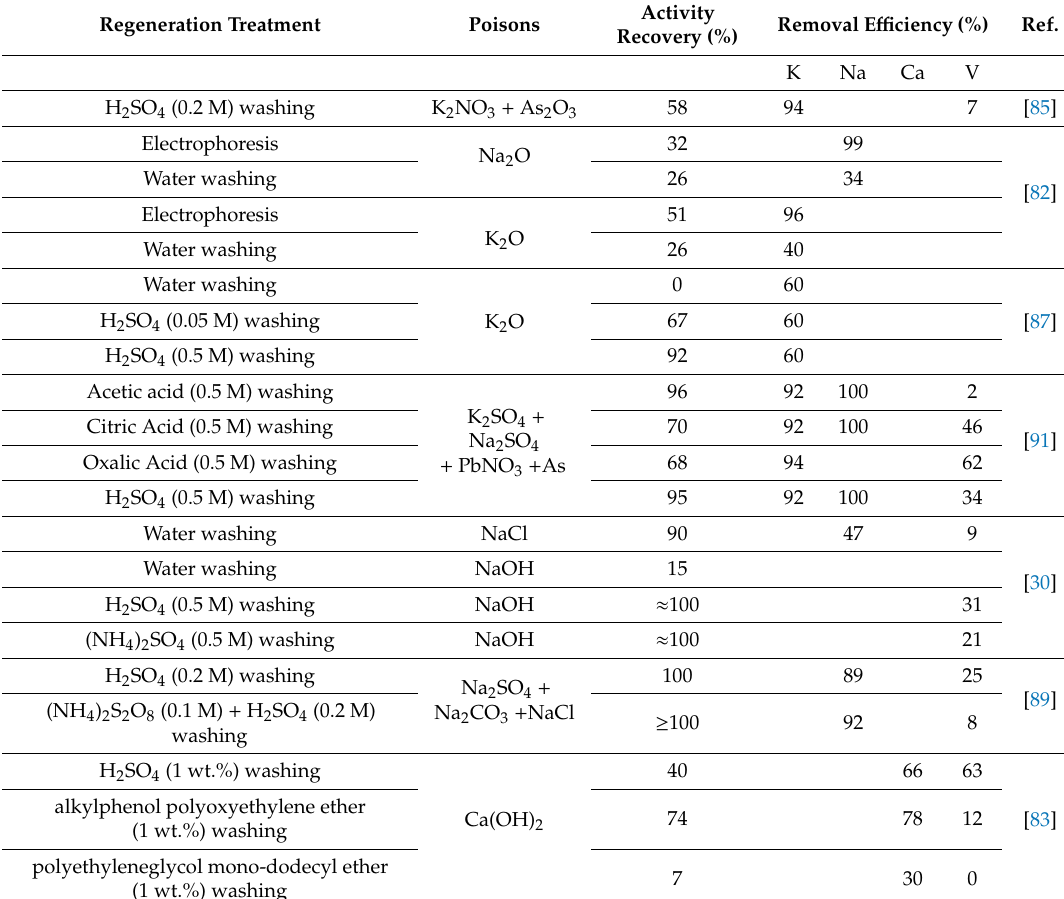
Table 4. The extent of SCR activity recovery and the corresponding removal of specific elements from poisoned VWT catalysts following the specified regeneration method. Regeneration